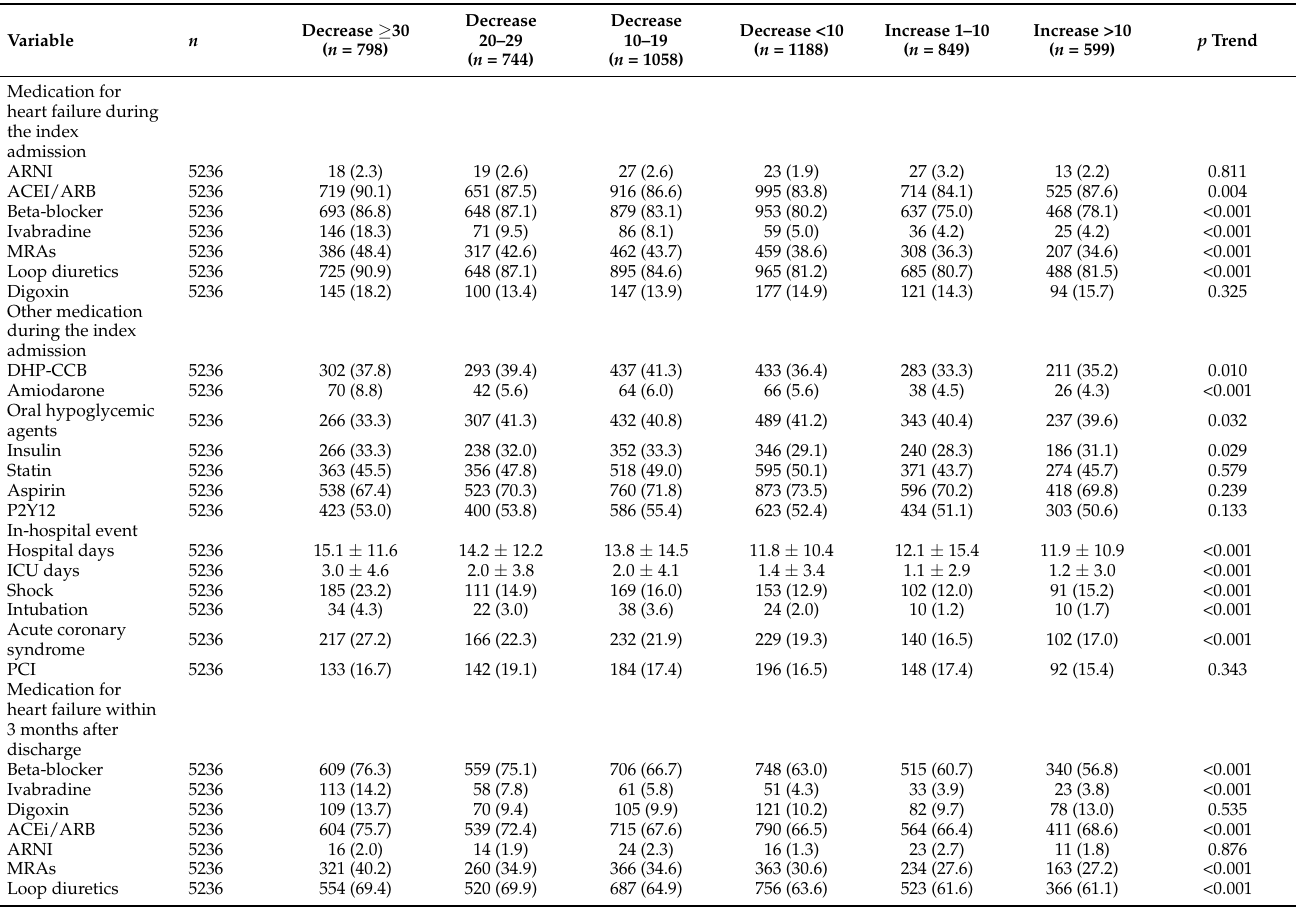
Table 2. Medications and in-hospital events of patients grouped by changes in heart rate from the admission day to the 90th day after